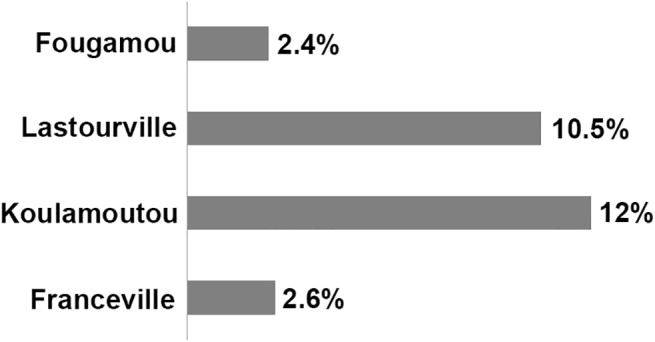
Prevalence of M. perstans according to the studied areas.